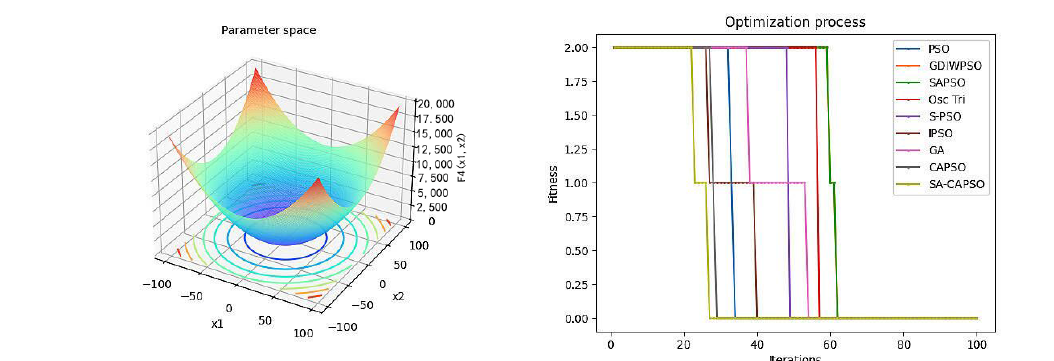
Figure 6. Two-dimensional function image and iterative curve of function F3.